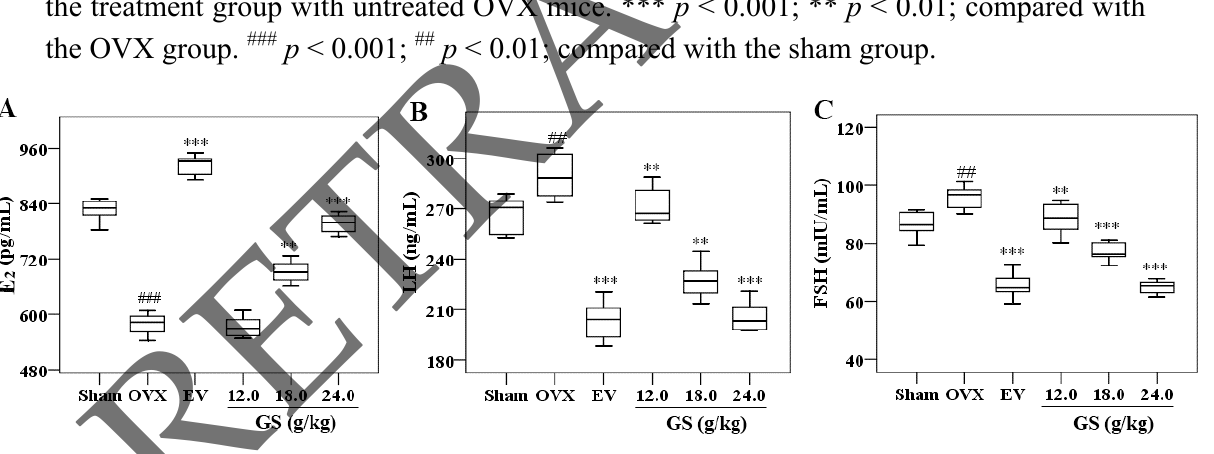
), luteinizing hormone (LH) 2 ( A ); LH ( B ) and 2